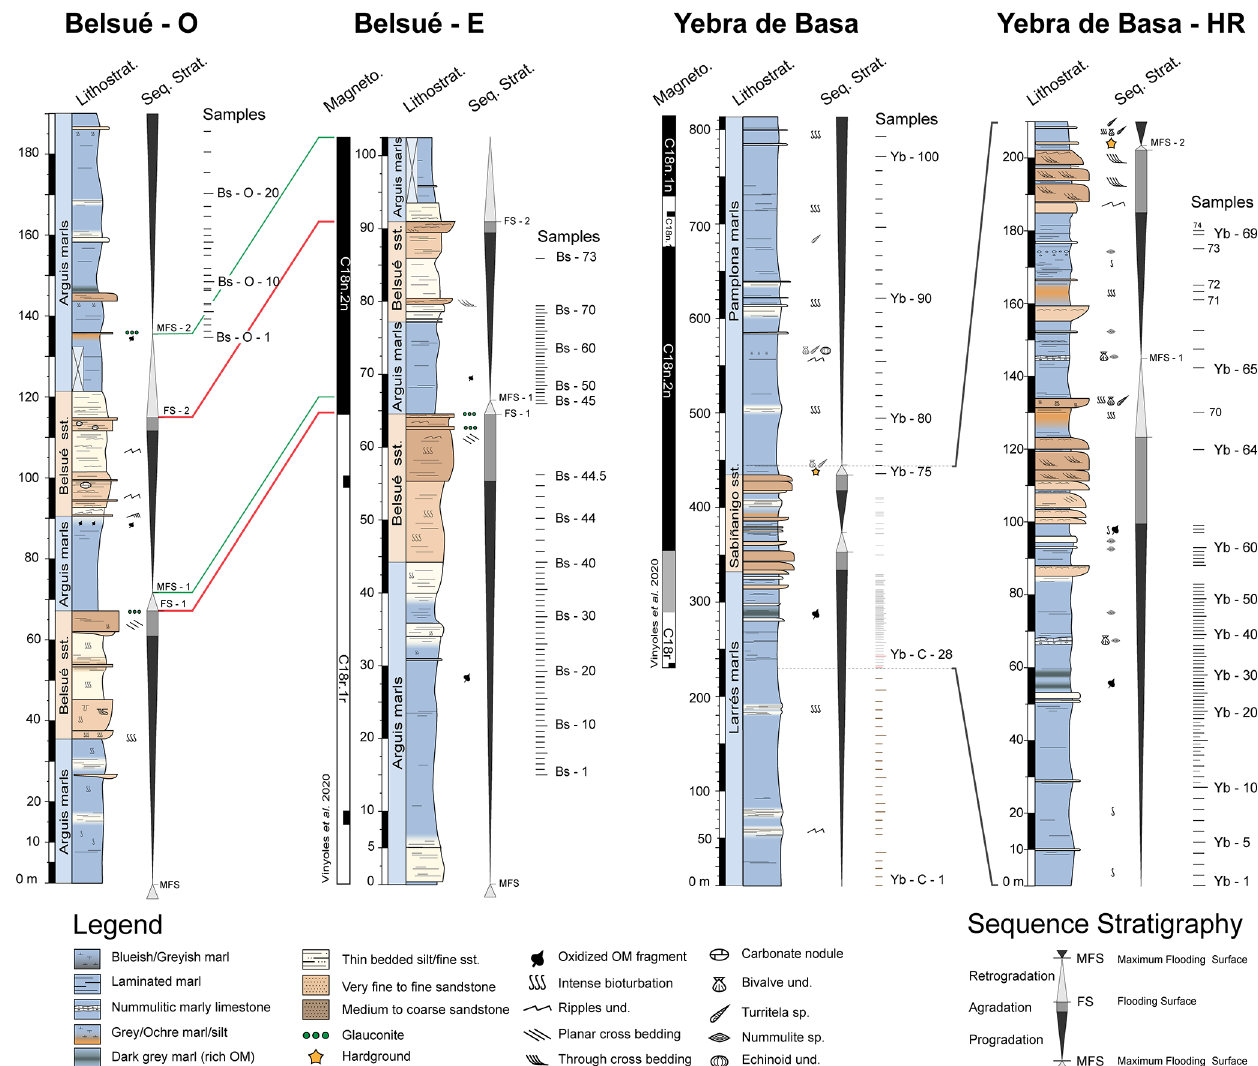
Figure 4. Stratigraphic logs of Belsué – East (BS-E), Belsué – West (BS-O), and Yebra de Basa, with a more complete high-resolution log (Yebra de Basa HR). Red lines represent flooding surfaces (FS), and green lines represent the maximum flooding surfaces (MFS) correlation. Facies interpretation of the sedimentary logs is represented by grey bars, being more proximal the grey bar and more distal the white. Abbreviations used are as follows: Magneto. for magnetostratigraphy, Lithostrat. for lithostratigraphy, and Seq. Strat. for sequence stratigraphy. The poor-exposure zones in Belsué are covered with a semi-transparent white rectangle with a black